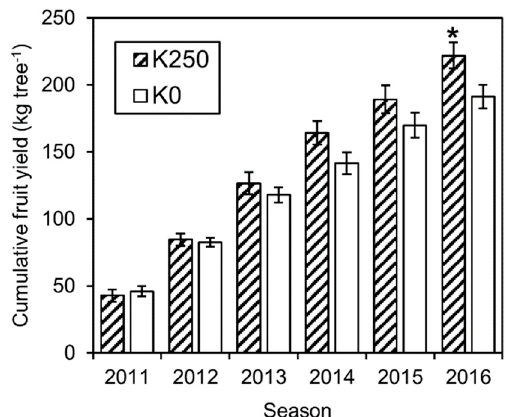
Figure 3. Influence of K fertilization on cumulative fruit yield. Experiment plots were fertilized either with an annual amount of 250 kg K ha − 1 (K250) or without K (K0). Cumulative fruit yield per tree over six seasons, from 2011 until 2016. Numbers are mean values of 14 replicates (trees) ± standard error of the mean (bars). Asterisks indicate statistically significant difference between K fertilization levels according to Student’s t -test ( p ≤ 0.05). Table 3. Implications of K fertilization on yields.